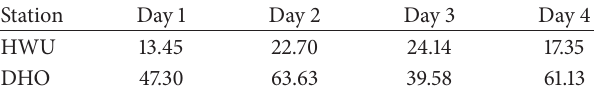
Table 2: The means of the VLF signals.